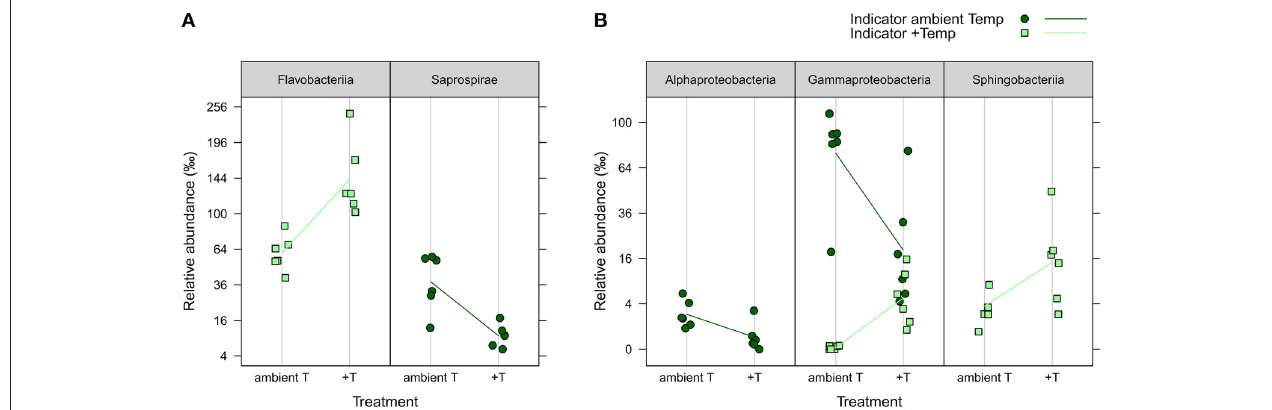
FIGURE 6 | iOTUs for temperature on seawater. Relative abundances in ‰ of single iOTUs for ambient (dark green circles) and increased (light green squares) temperature in the water column in (A) week 4 and (B) week 8 summarized at class level ( q ≤ 0.05) per sample ( n = 6). Lines connect the mean relative abundances between both treatment levels. + T, increased temperature treatment.